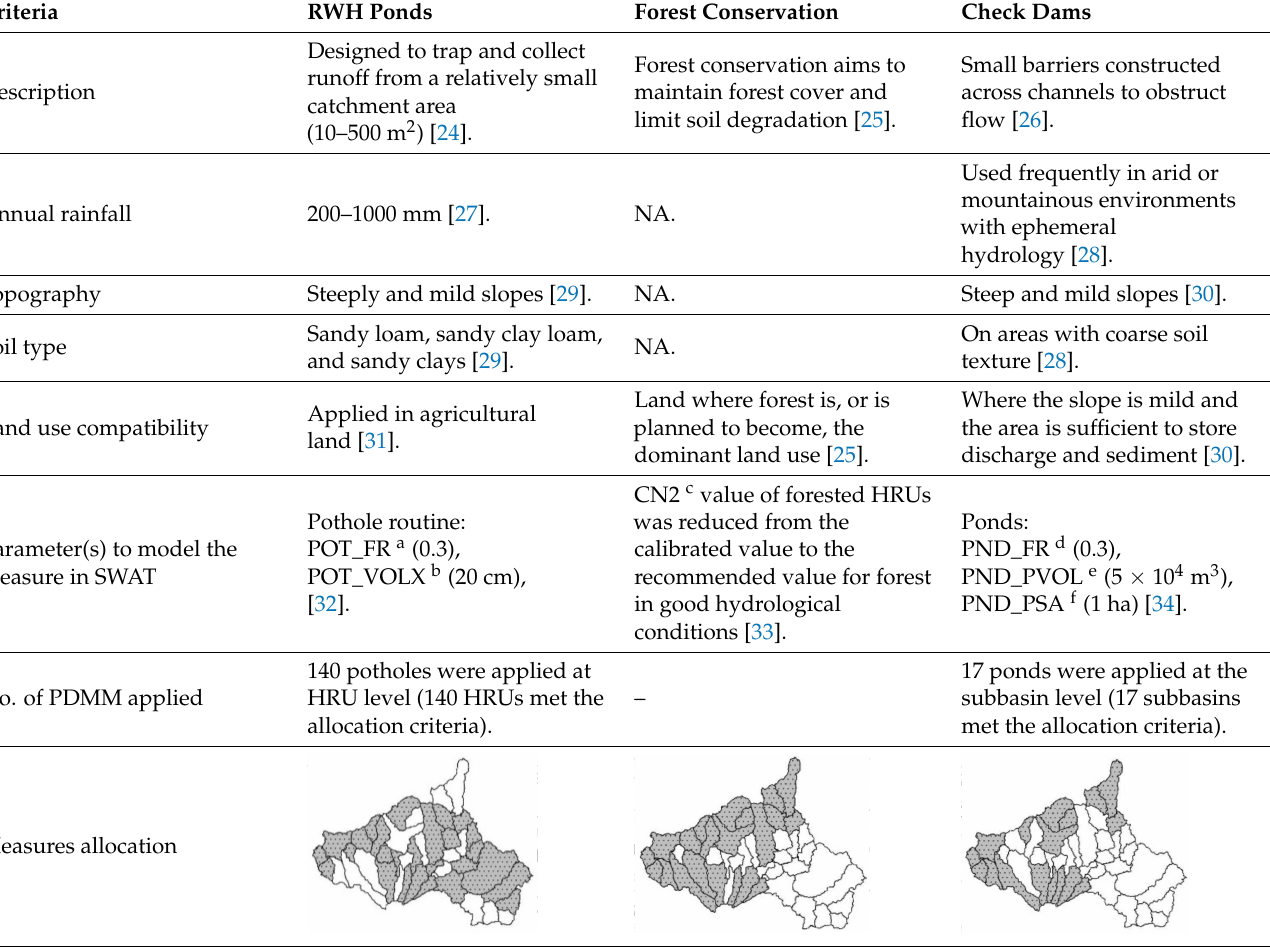
Table 2. Evaluation criteria to identify interventions for drought management in study